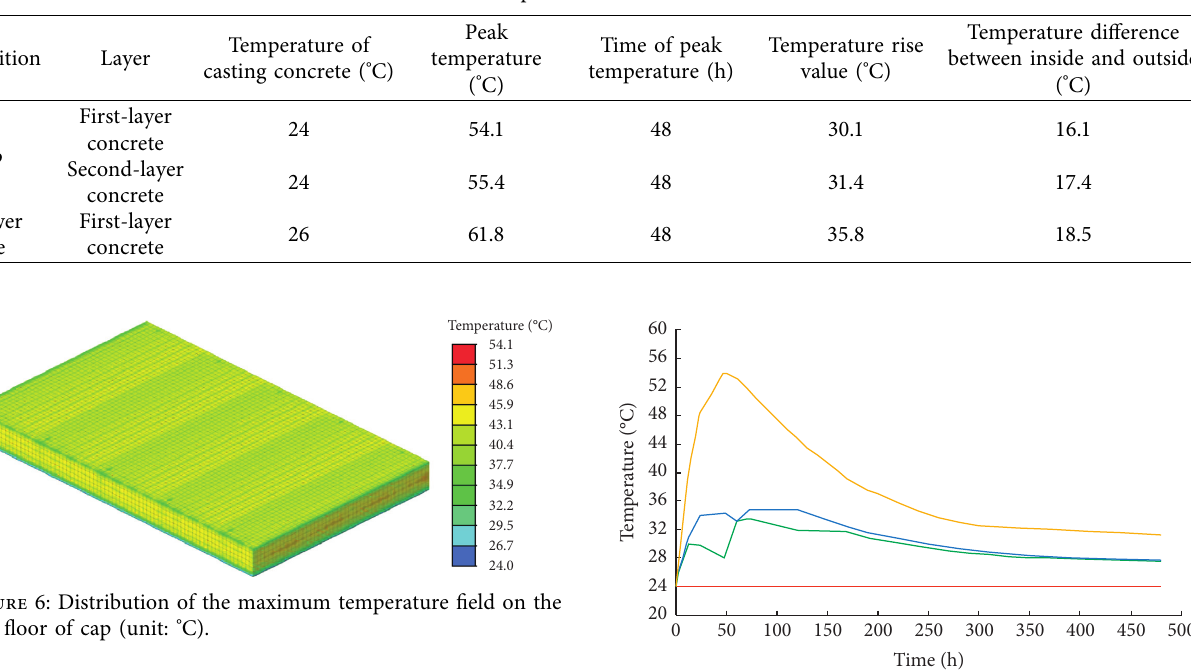
Table 3: Temperature calculation results.